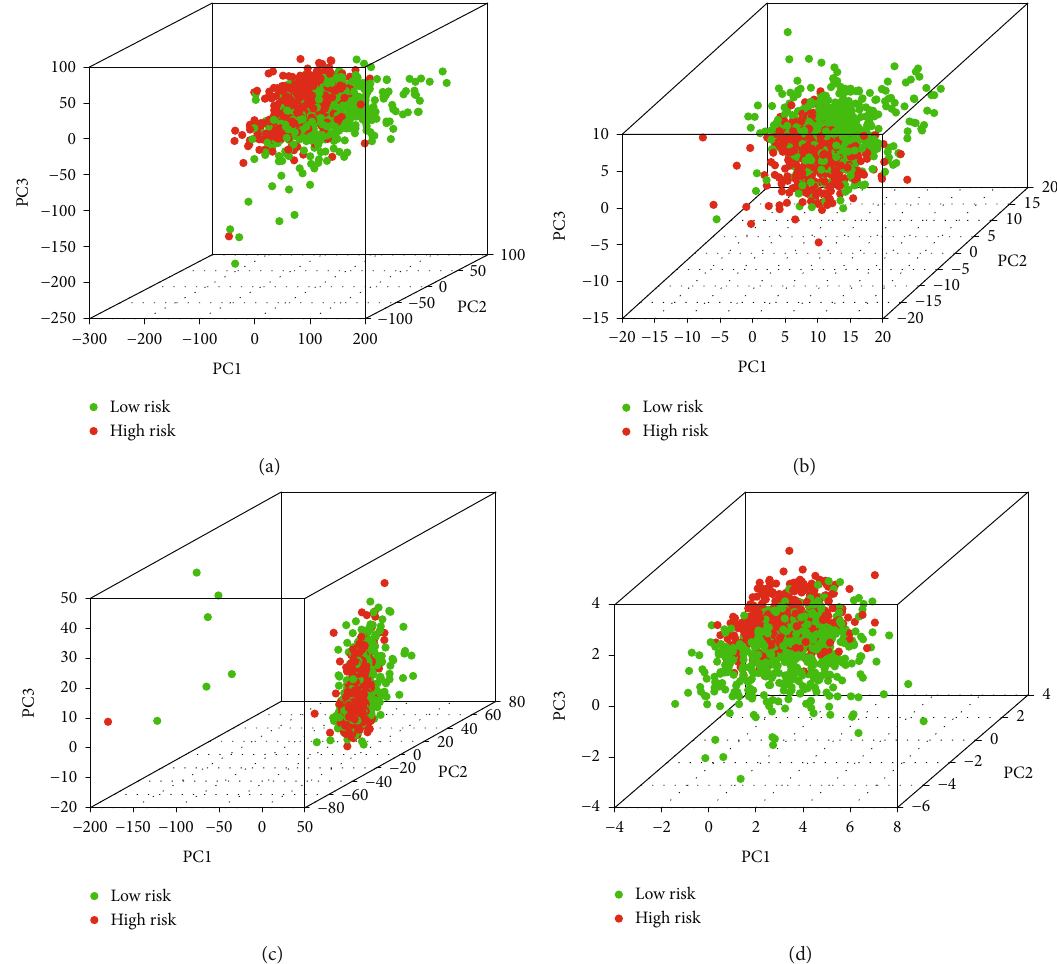
Figure 4: Principal component analysis. A comparison of gene expression levels in low- and high-risk populations, as determined by the expression of all examined genes (a), necroptosis-related genes (b), and lncRNAs (c) and the 7 lncRNAs of the prognostic signature